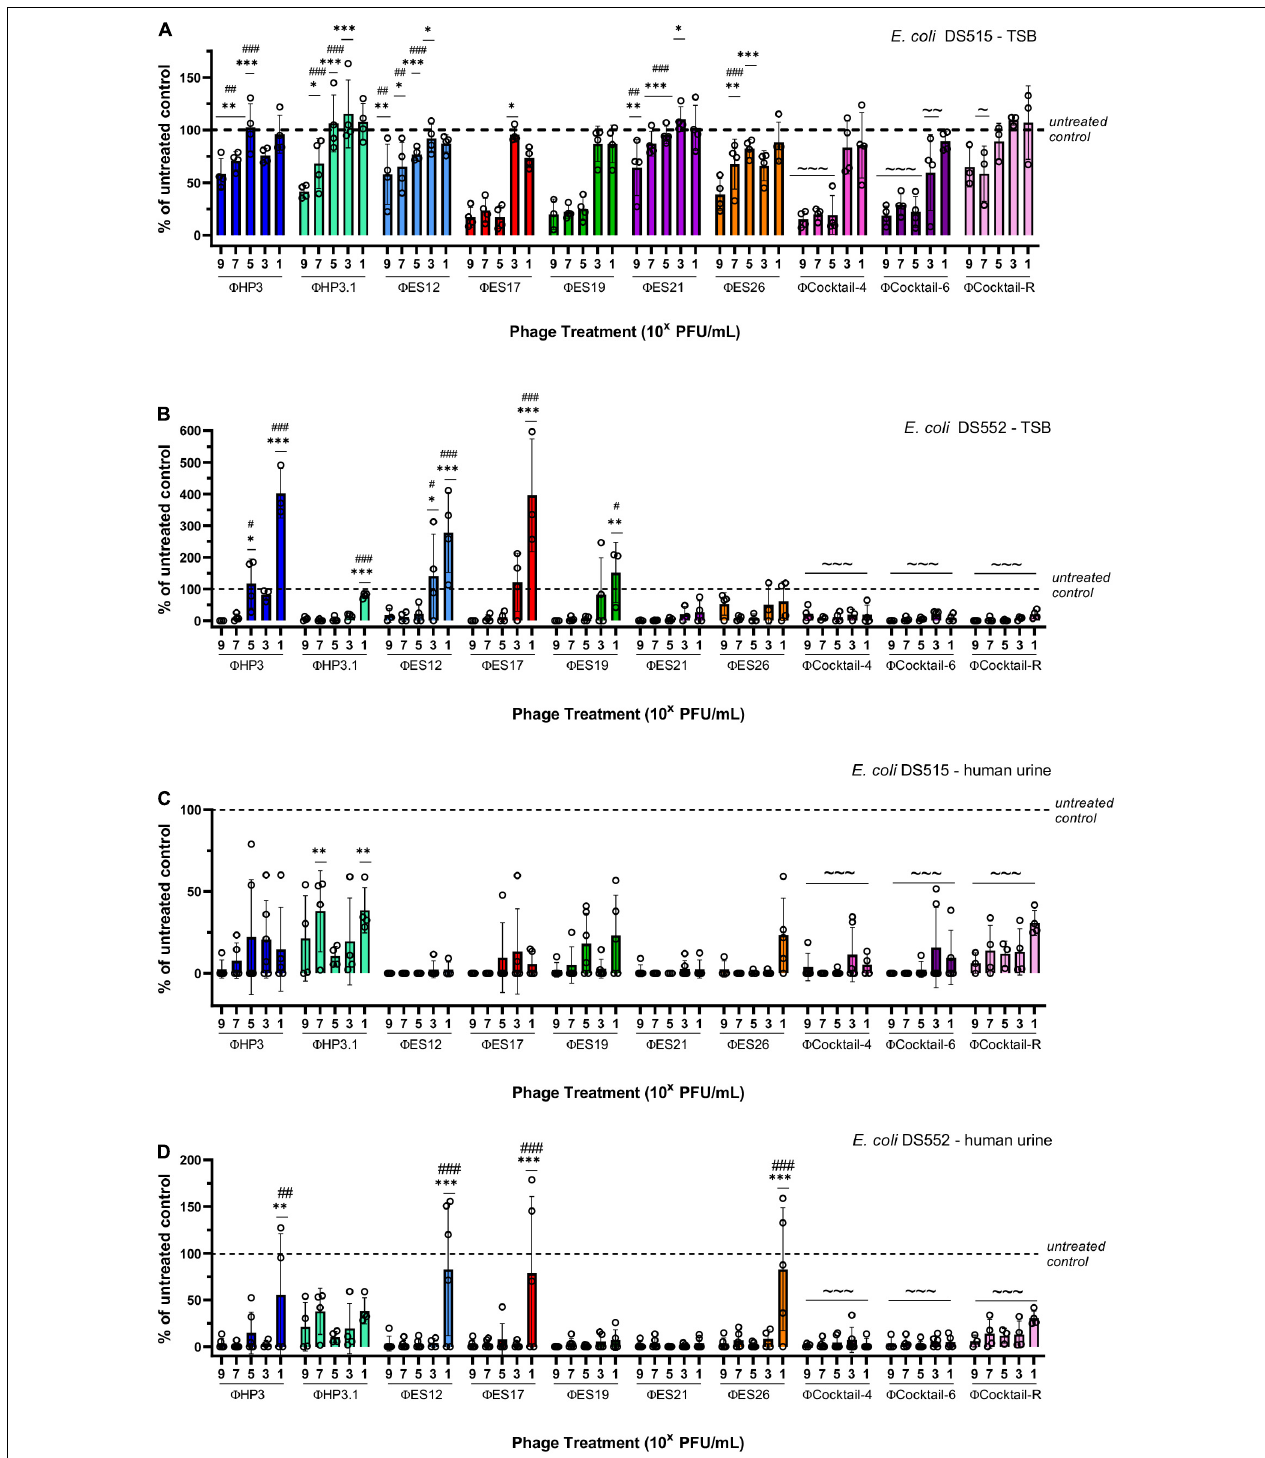
FIGURE 5 | Design of anti-biofilm phage cocktails. Results depict the percentage of viable biofilms after 24-h treatment with phage, using the untreated control biofilm as the denominator. Biofilms of two strains of E. coli (DS515 and DS552) were treated with increasing doses of individual phage and three phage cocktails ( (cid:56) Cocktail-4: HP3, ES17, ES21, and ES26; (cid:56) Cocktail-6: HP3, ES12, ES17, ES19, ES21, and ES26; (cid:56) Cocktail-R: HP3, ES17, ES19, and HP3.1). Biofilms were grown in TSB (A,B) and human urine (C,D) . Symbols denote significant difference; ∗ compared to corresponding treatment with (cid:56) Cocktail-6, # compared to corresponding treatment with (cid:56) Cocktail-4, and ∼ compared to the untreated control. ∗ /#/ ∼ p < 0.05, ∗∗ /##/ ∼∼ p < 0.01, ∗∗∗ /###/ ∼∼∼ p < 0.001.